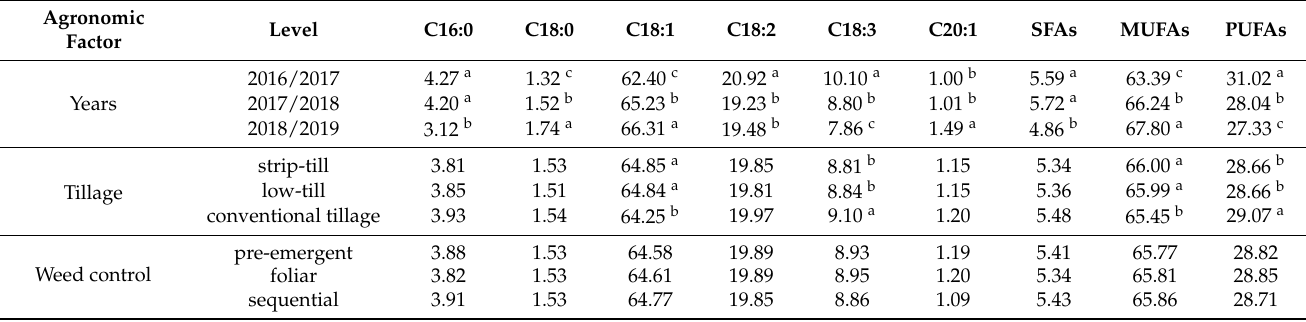
Table 4. Fatty acids (%) (main